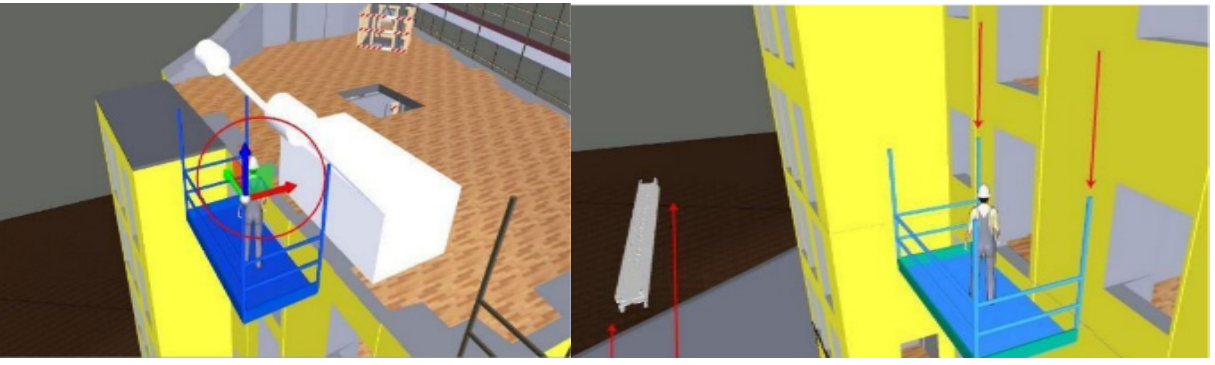
Figure 22. Analysis of suspended platform.